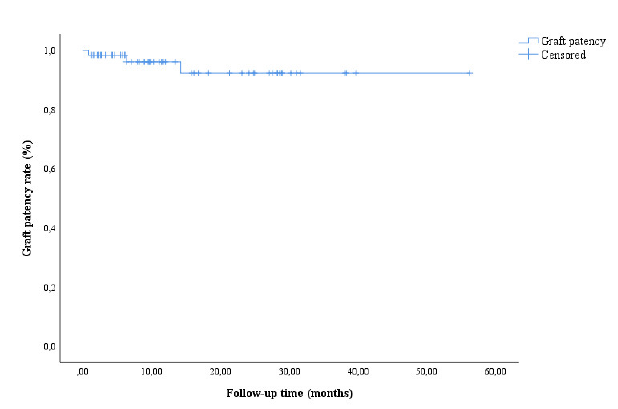
Fig. 2 - Survival curve related to left carotid-subclavian bypass graft patency.